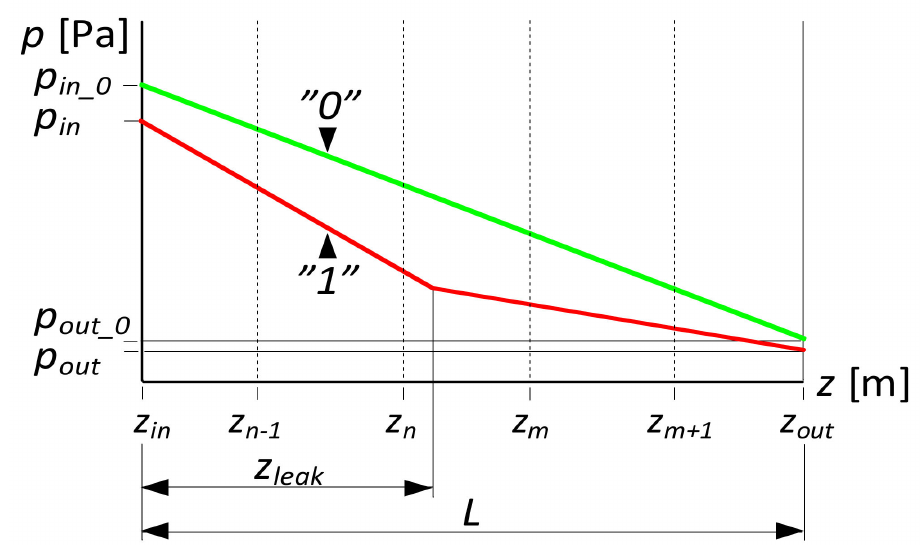
Figure 1. Lines of pressure distribution during no-leak conditions and after leak